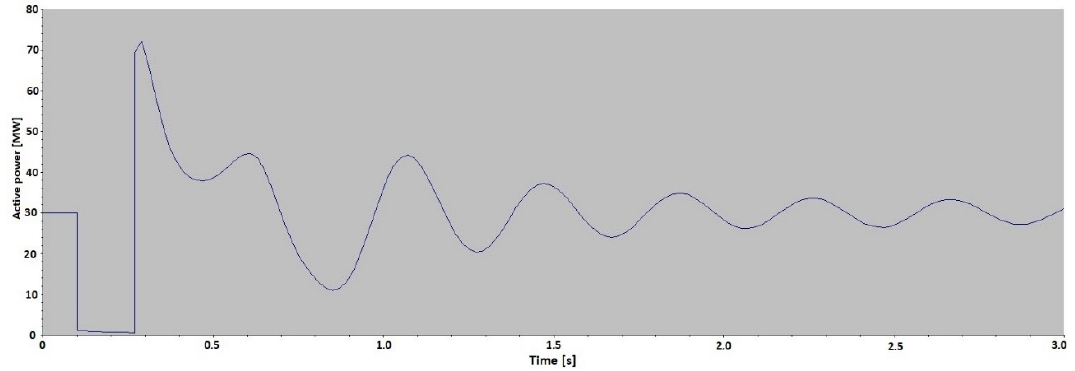
Figure 19. Simulation results of active power of Generator 2 during the three-phase fault with the fault duration of 170 ms.